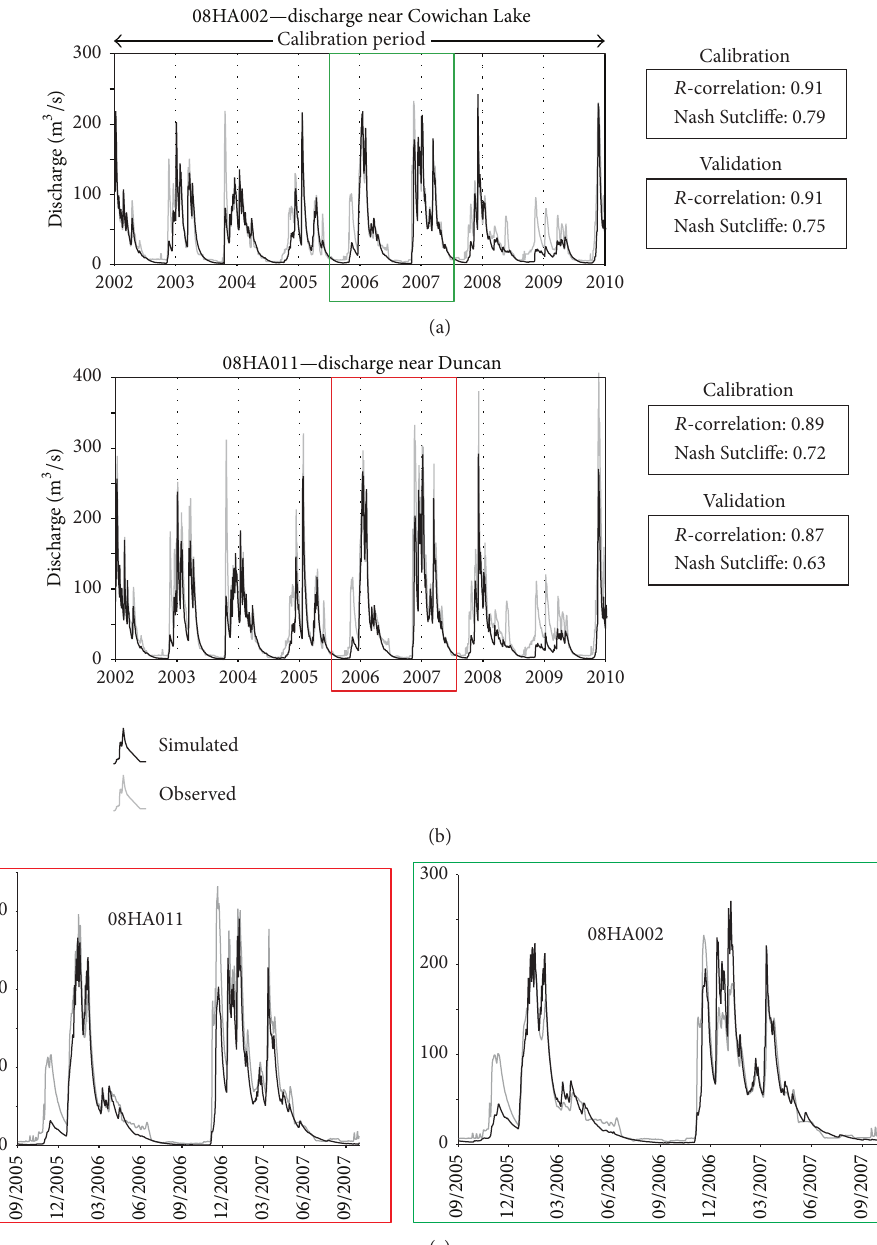
Figure 10: Cowichan River discharge calibration results at (a) hydrometric station 08HA002 and (b) at hydrometric station 08HA011 and (c) at higher resolution for both stations. The calibration statistics are also shown for the calibration period (2002–2010) and the validation period